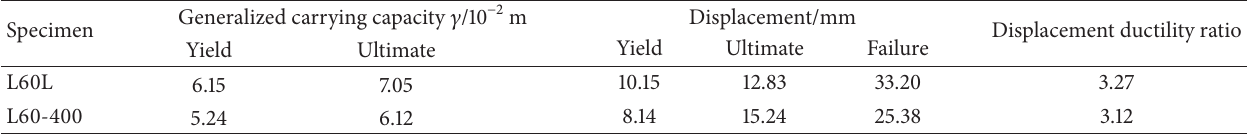
Table 3: Behavior of L-shaped columns with different